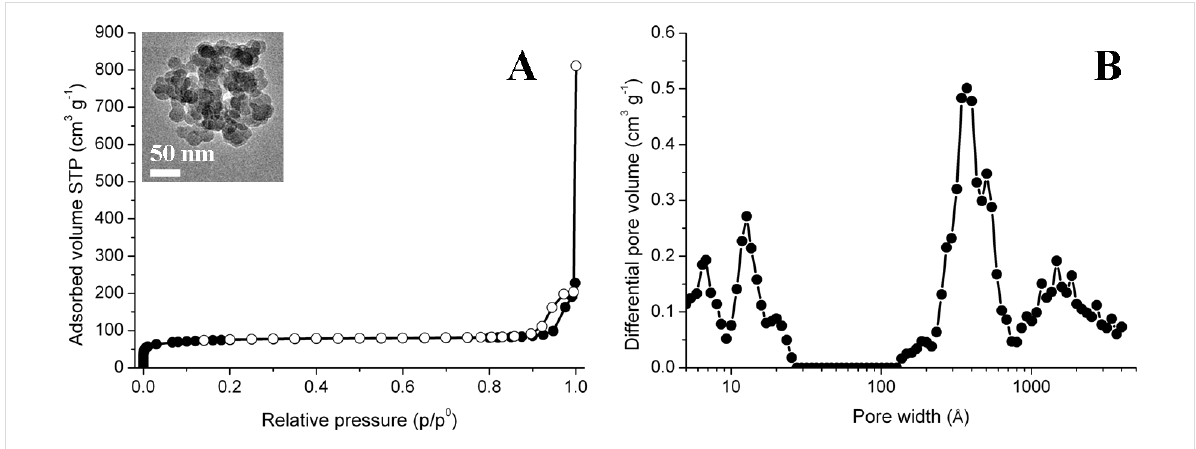
Figure 3: N 2 adsorption-desorption isotherm at 77 K (A) and DFT pore size distribution curve of 75TEOS/25PS 308 - b -PEO 250 silica powder (B). Dark symbols refer to the adsorption branch of the isotherm, empty symbols to the desorption branch. Inset shows the TEM micrograph of the powdery samples obtained by solvent-casting deposition.